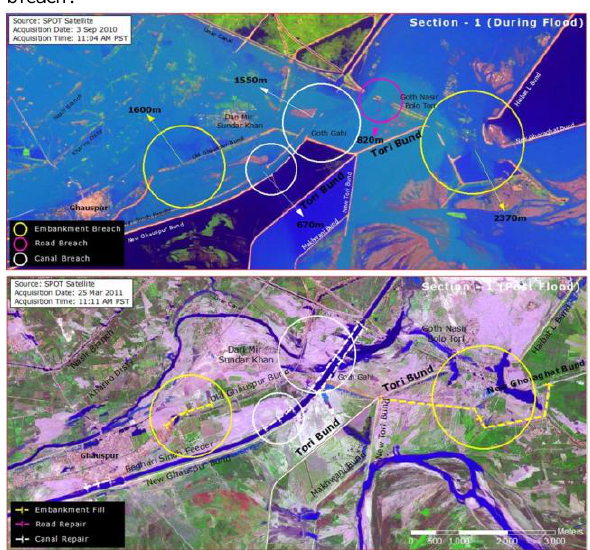
Figure 5. Rehabilitation of Tori Breach,